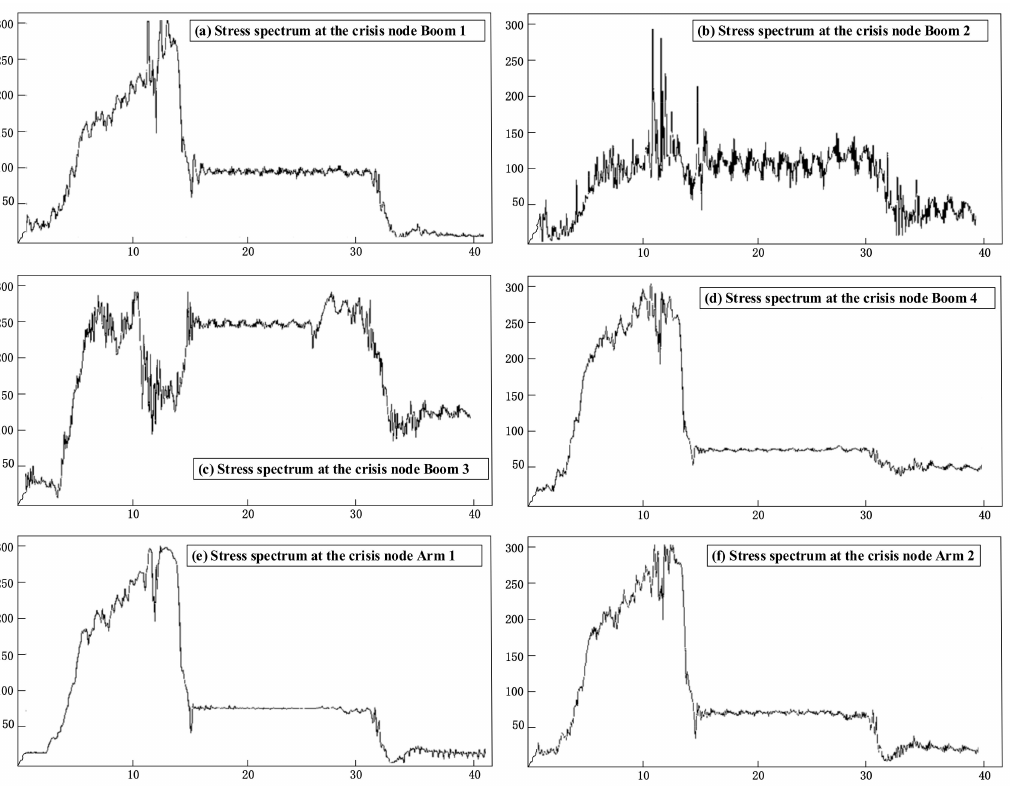
Figure 14. The stress spectra at the risk nodes on the boom and